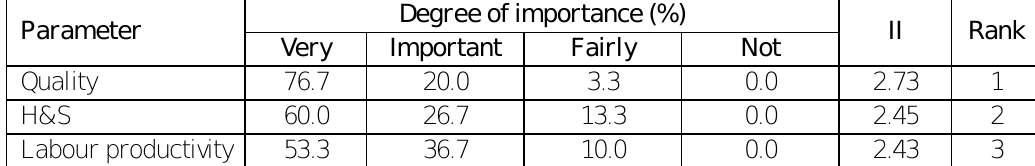
Table 1: Importance of contractor H&S, labour productivity and quality to PMs